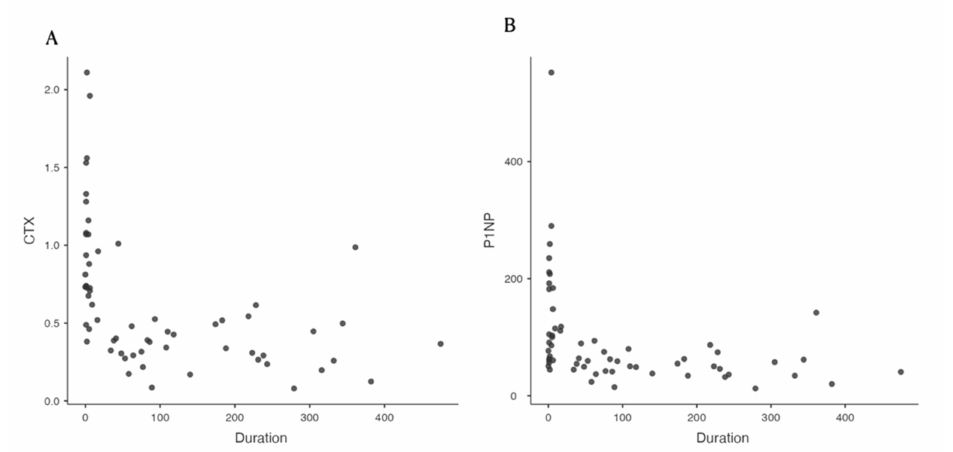
Figure 2. The scatterplot of bone biomarker levels against duration. Serum concentrations of carboxy- terminal collagen crosslinks ( A ) and procollagen type 1 intact N-terminal propeptide ( B ) were higher in the acute phase than in the chronic